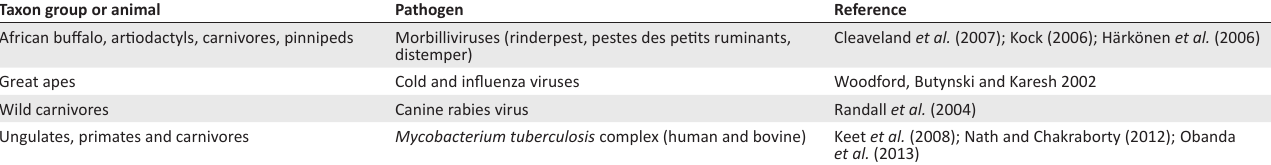
TABLE 2: Examples of wildlife taxa that are impacted by spillover infection from domestic animal or human reservoirs of disease. Taxon group or